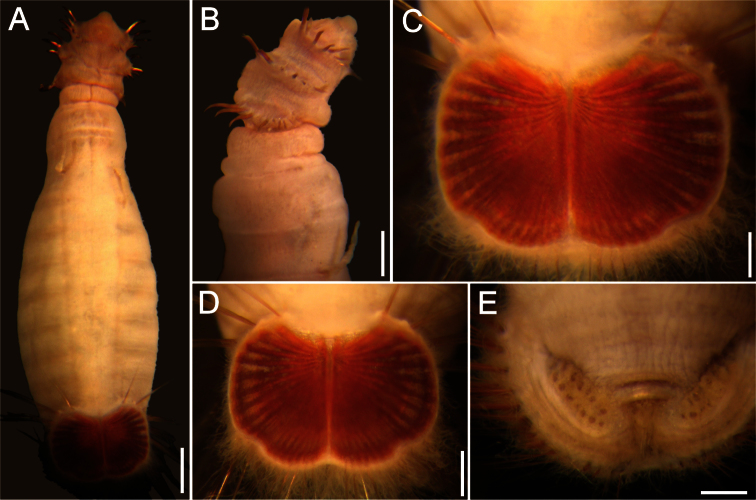
Petersenaspis palpallatoci sp. n. A Holotype (MNHN 1551), ventral view B Same, anterior end, lateral view C Same, ventro-caudal shield, frontal view D Paratype (MNHN 1552), ventro-caudal shield, frontal view E Same, branchial plate, frontal view, branchiae and papillae removed. Bars: A 1 mm B 0.7mm C 0.3 mm D 0.5 mm E 0.4 mm.